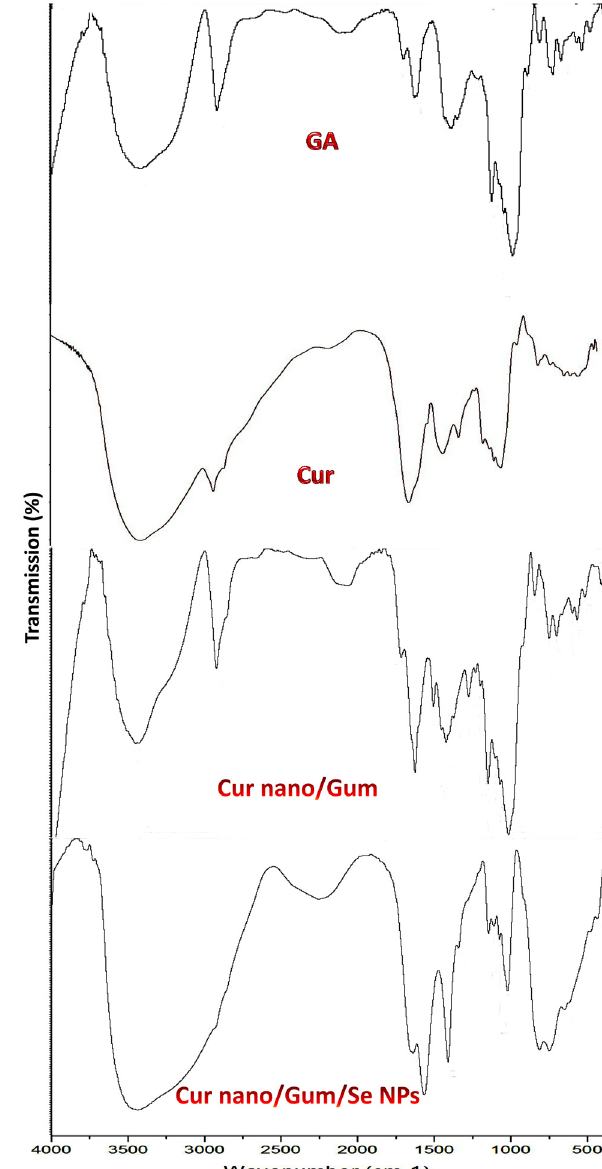
Figure 2: FTIR spectra of GA, Cur, NC ( Cur nano/Gum ) , and NC/NSe composite ( Cur nano/Gum/Se NPs )